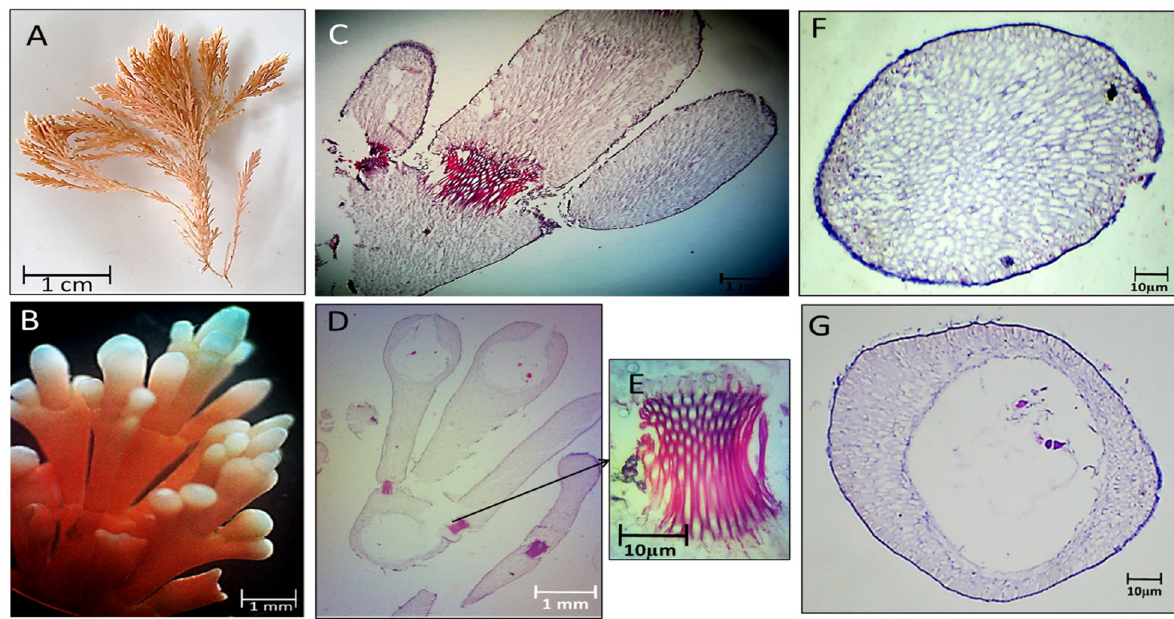
Fig. 2 Morphological and anatomical description of C. officinalis thallus during autumn 2019. A Habit view of thallus, B Magnification of the thallus frond C L.S. of thallus showing genicula and intergenicula tiers. D L. S. through mature geniculum and intergenicula, E Mature geniculum with polygonal cells. F Cross-section through intergeniculum G Cross-section through tetrasporangial